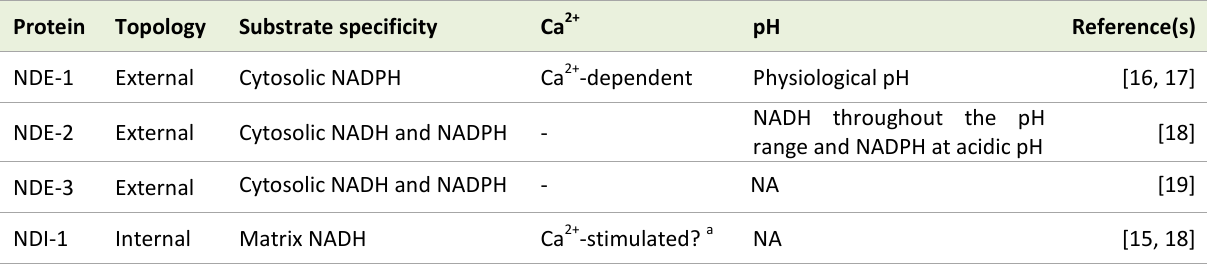
TABLE 1. Main features of N. crassa alternative NAD(P)H dehydrogenases.